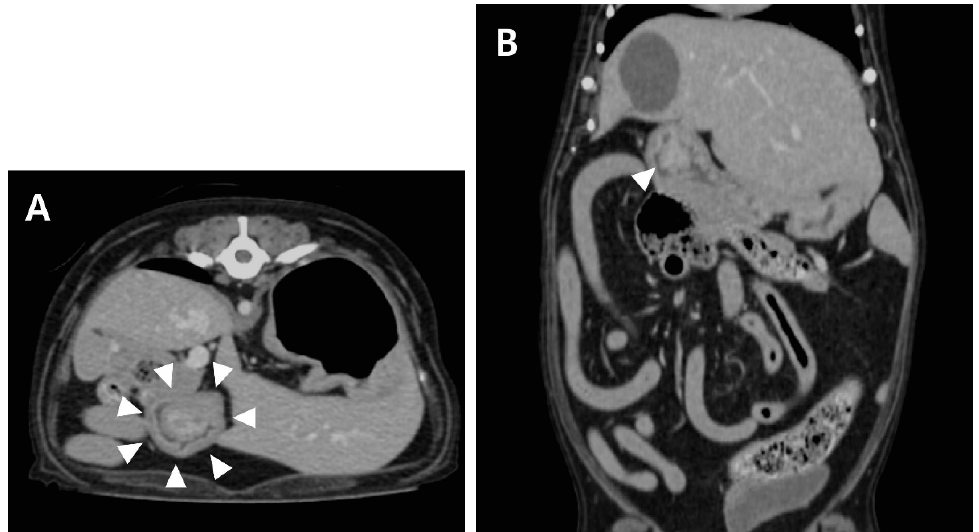
Figure 2. Post-contrast transverse ( A ) and dorsal ( B ) CT images of the abdomen. A wide-based, polypoid mass (arrowhead) with heterogeneous contrast enhancement.